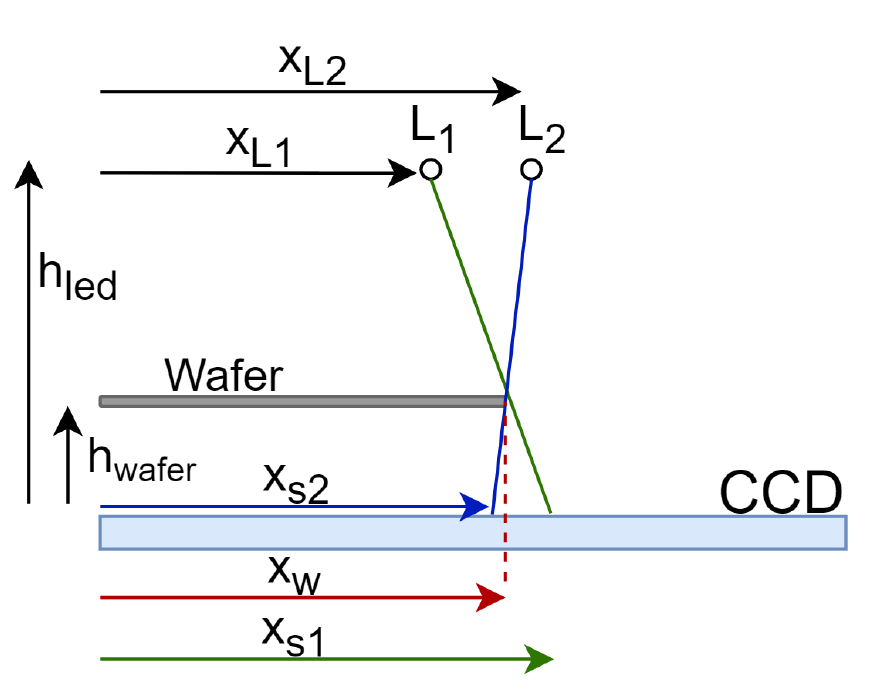
Figure 19. A CCD sensor with 2 LEDs, showing the actual position of the wafer x w , the shadow created by the first led x s 1 and second led x s 2